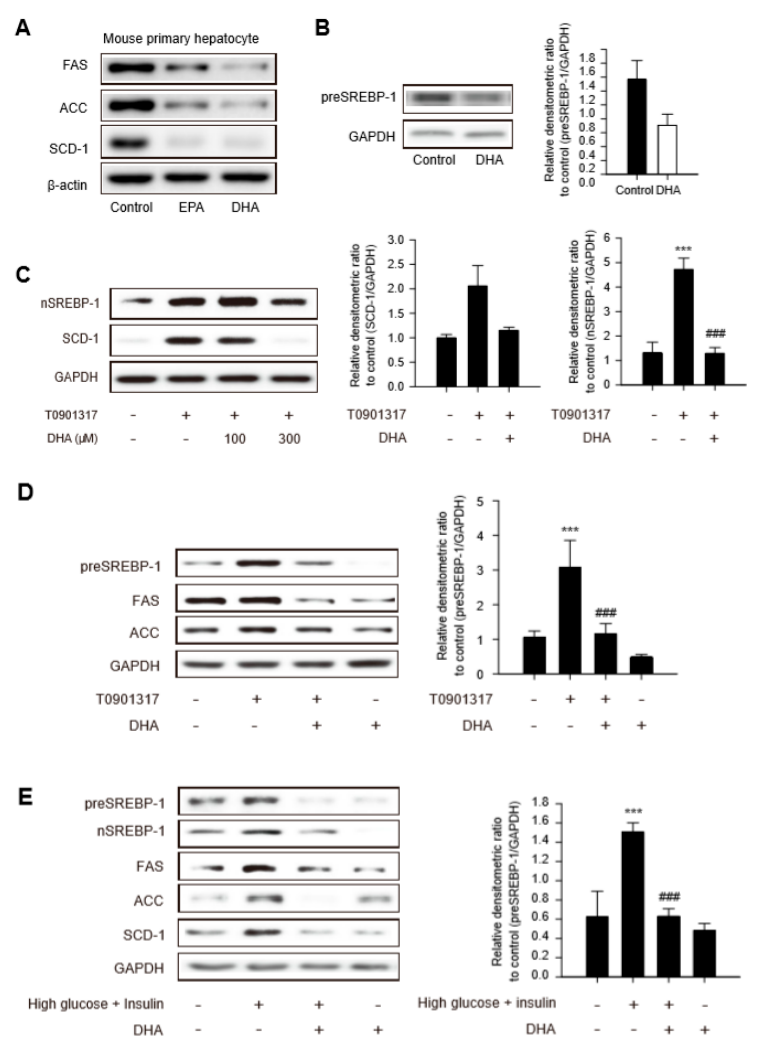
Figure 1. Decrease in lipogenesis enzymes after docosahexaenoic acid (DHA) treatment. ( A , B ) The protein expression level of fatty acid synthase (FAS), acetyl-coenzyme A carboxylase (ACC), stearoyl-CoA desaturase-1 (SCD-1) and precursor form of SREBP-1 (preSREBP-1). Mouse primary hepatocytes were treated with DHA 300 µ M or eicosapentaenoic acid (EPA) 300 µ M for 12 h. Data represent means ± SD ( n = 5). GAPDH: Glyceraldehyde 3-phosphate dehydrogenase. ( C ) In order to screen an optimal DHA concentration that exerts potent antilipogenic e ff ects, primary hepatocytes were treated with DHA 100 µ M and 300 µ M for 12 h followed by T0901317 (T090), liver X receptor (LXR) agonist for additional 12 h. Data represent means ± SD ( n = 5), *** p < 0.005 compared with the control group; ### p < 0.005 compared with the T090-treated group ( D ) E ff ects of DHA on the expression of lipogenic proteins stimulated by LXR agonist. Primary hepatocytes were treated with DHA 300 µ M for 12 h followed by T090 for additional 12 h. Data represent means ± SD ( n = 5), *** p < 0.005 compared with the control group; ### p < 0.005 compared with the T090-treated group ( E ) E ff ects of DHA on the expression of lipogenic proteins in high glucose with insulin condition. Primary hepatocytes were treated with DHA 300 µ M for 12 h followed by 30 mM high-glucose medium for 30 min and further incubation with 200 nM insulin for 24 h. Data represent means ± SD ( n = 3), *** p < 0.005 compared with the control group; ### p < 0.005 compared with the high glucose and insulin